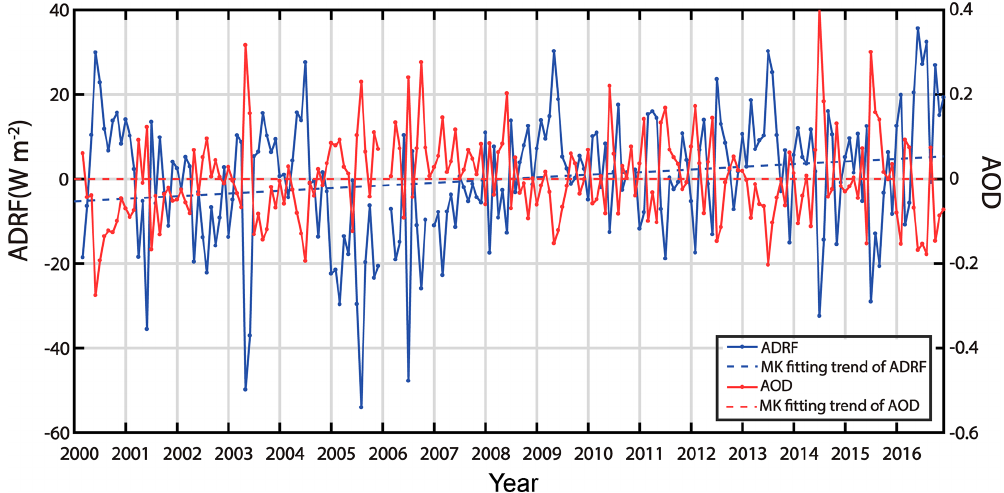
Figure 8. Time series of monthly mean ADRF (blue) and AOD (red) in eastern China from 2000 to 2016. These data are deseasonalized. Dashed lines represent the Mann–Kendall (MK) fitting trend of ADRF and AOD.